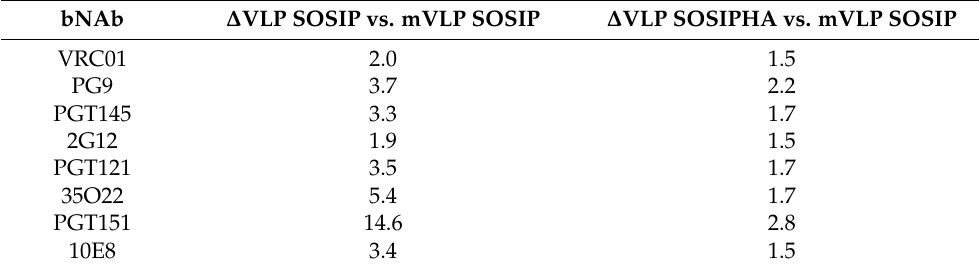
Table 2. Fold-reduction in bNAb binding for ∆ VLPs expressing SOSIP or SOSIPHA Env.